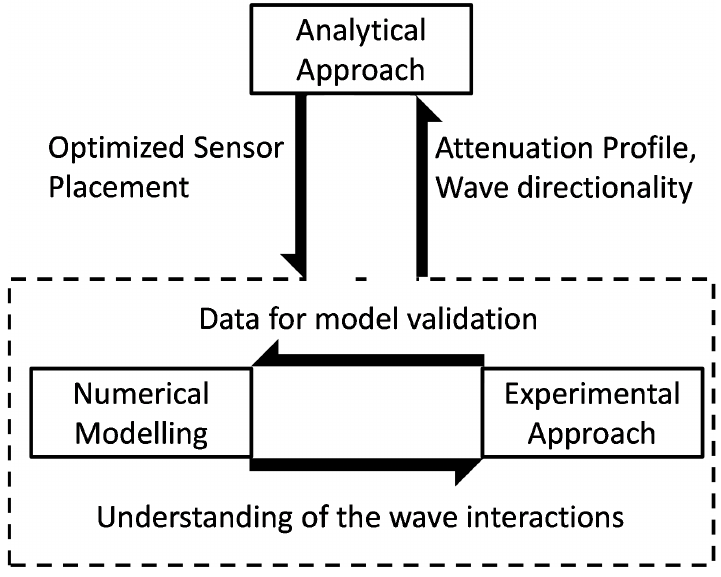
Figure 1. Synergy and data transfer between three approaches [11].